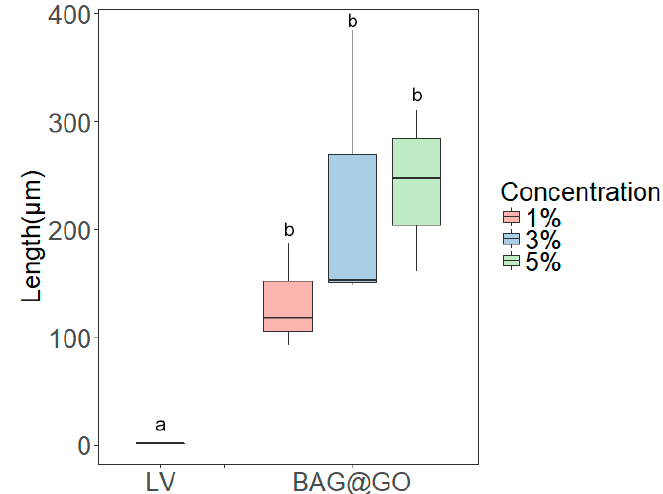
Figure 7. Anti-demineralization length comparison of orthodontic bonding adhesive containing LV and BAG@GO by Image J analysis. The same letter indicates no statistically significant difference between the groups ( p < 0.05) by Duncan’s multiple comparison test. Error bars are shown ± standard deviation.